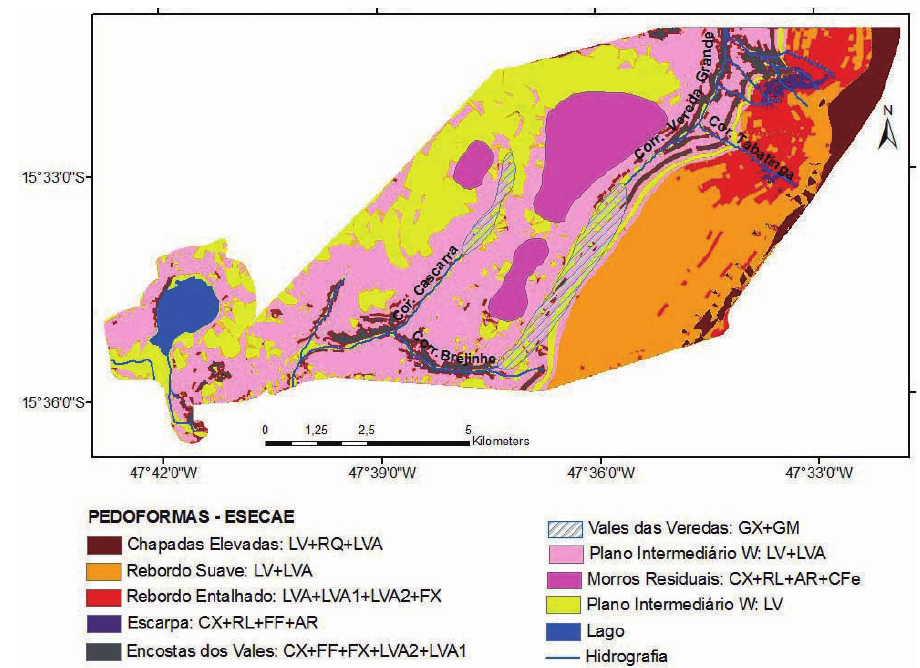
figura 3. mapa de pedoformas da estação ecológica de Águas emendadas,